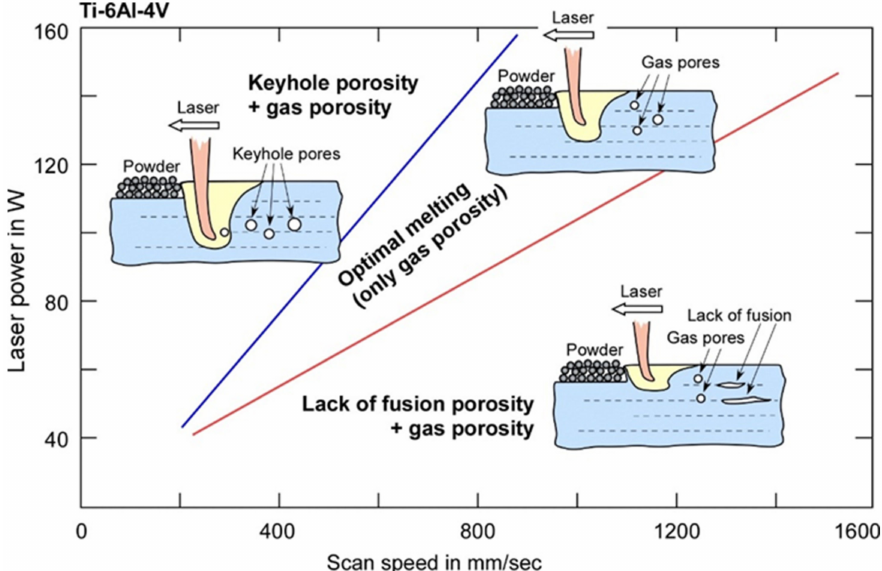
Figure 3. Overview on the formation of the different defect types as a function of laser power and scan speed, assuming that all other parameters (pattern, hatch distance, layer thickness) are kept constant; L-PBF manufactured Ti–6AL–4V; figure modified from [27]. The triangle in the middle defines the processing